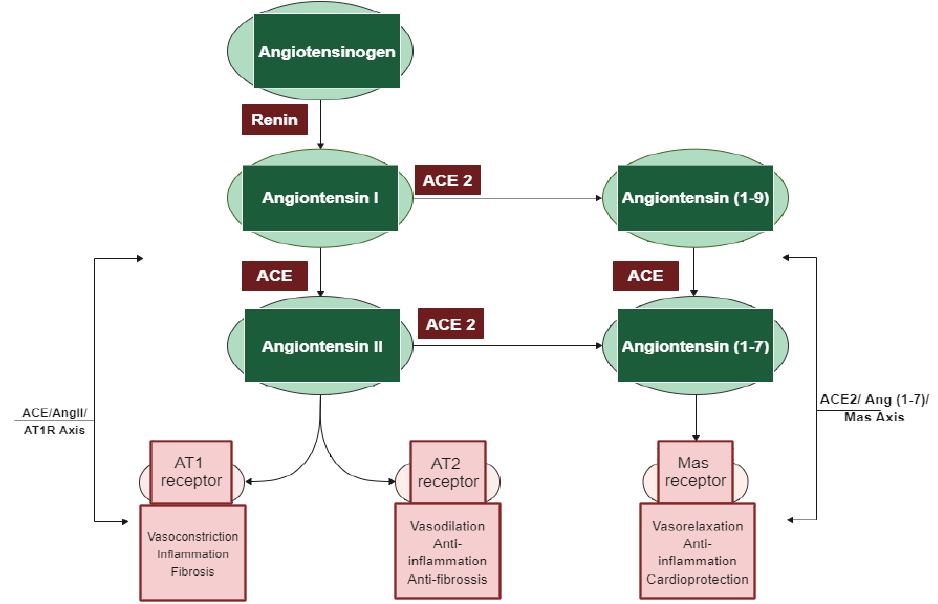
Figure 1. The two main axes of the renin–angiotensin system (RAS) cascade and their opposing effects. Adapted from D’ardes et al. [23].